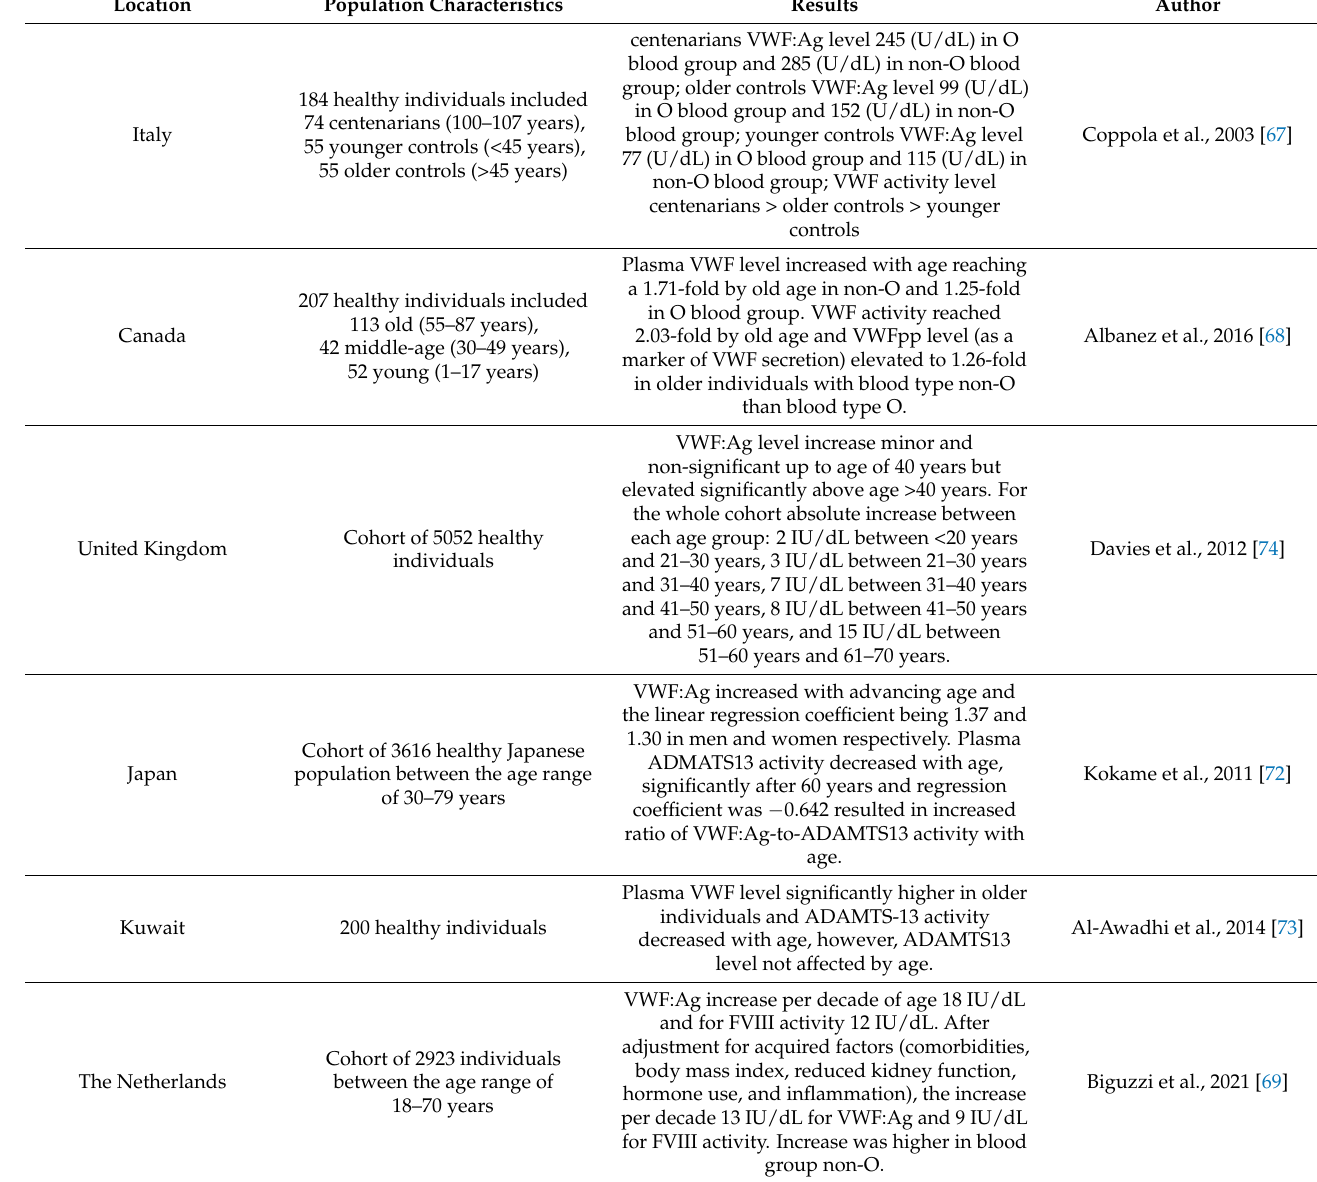
Table 1. Effect of age on Von Willebrand factor in the healthy